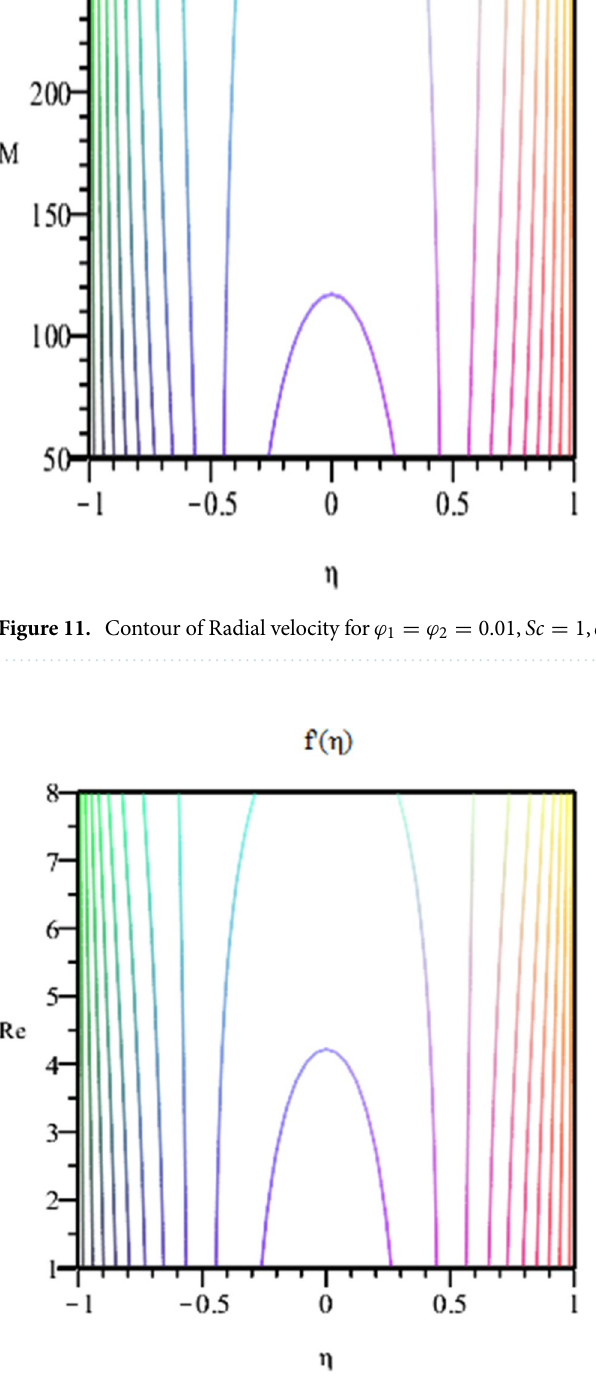
Figure 12. Contour of Radial velocity with increasing of Reynolds number fields for ϕ 1 = ϕ 2 = 0.01, Sc = 1, α = 3, M = 50, Pr = 6.2